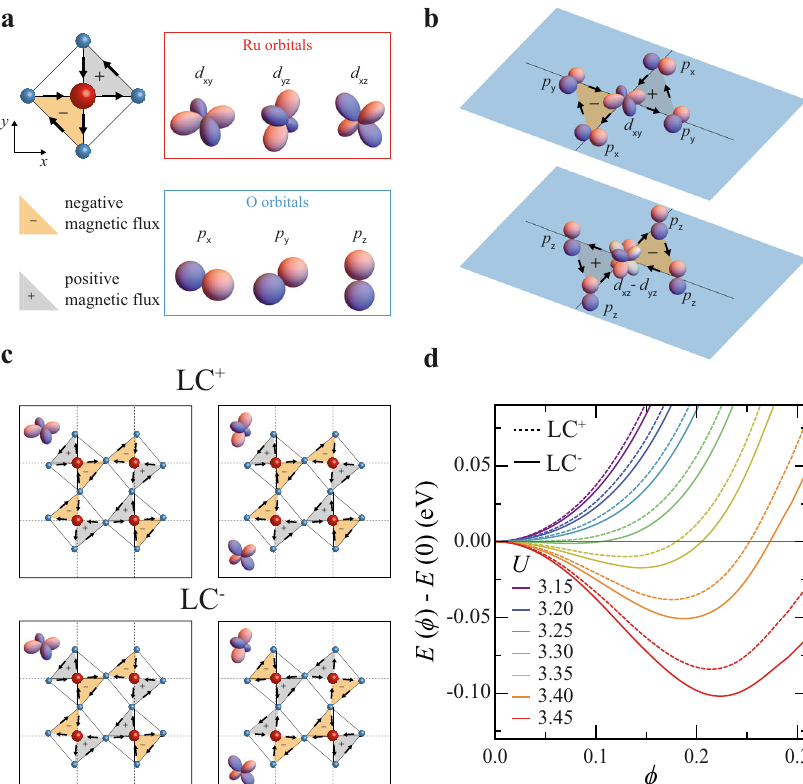
Fig. 5 Magnetism due to orbital loop currents in SRO 214 . a Illustration of the RuO 4 plaquette and of the corresponding d -orbitals for the Ru atoms (red box) and p -orbitals for the O atoms (light blue box) with asymmetric loop current distributions generating magnetic fl ux pointing inward (yellow triangle with ‘ − ’ symbol) or outward (grey triangle with ‘ + ’ symbol) the RuO 4 plane. b Possible orbital loop currents for a given RuO 4 plaquette associated with the Ru – O hybridization of the d xy orbitals (top) and of the ( d xz , d yz ) orbitals (bottom). c Loop current states with equal (LC + state) and opposite sign (LC − state) of the magnetic fl ux associated with the xy - and z -orbital sectors of the RuO plaquettes in the SRO 214 supercell. d , Free energy E ( ϕ ) − E (0) of the LC + (dashed lines) and LC − states (solid lines) calculated at T = 50 K for different values of the d – p Coulomb interaction U ( U values given in eV units are speci fi ed in the fi gure legend) as a function of the order parameter ϕ which sets the amplitude of the bond